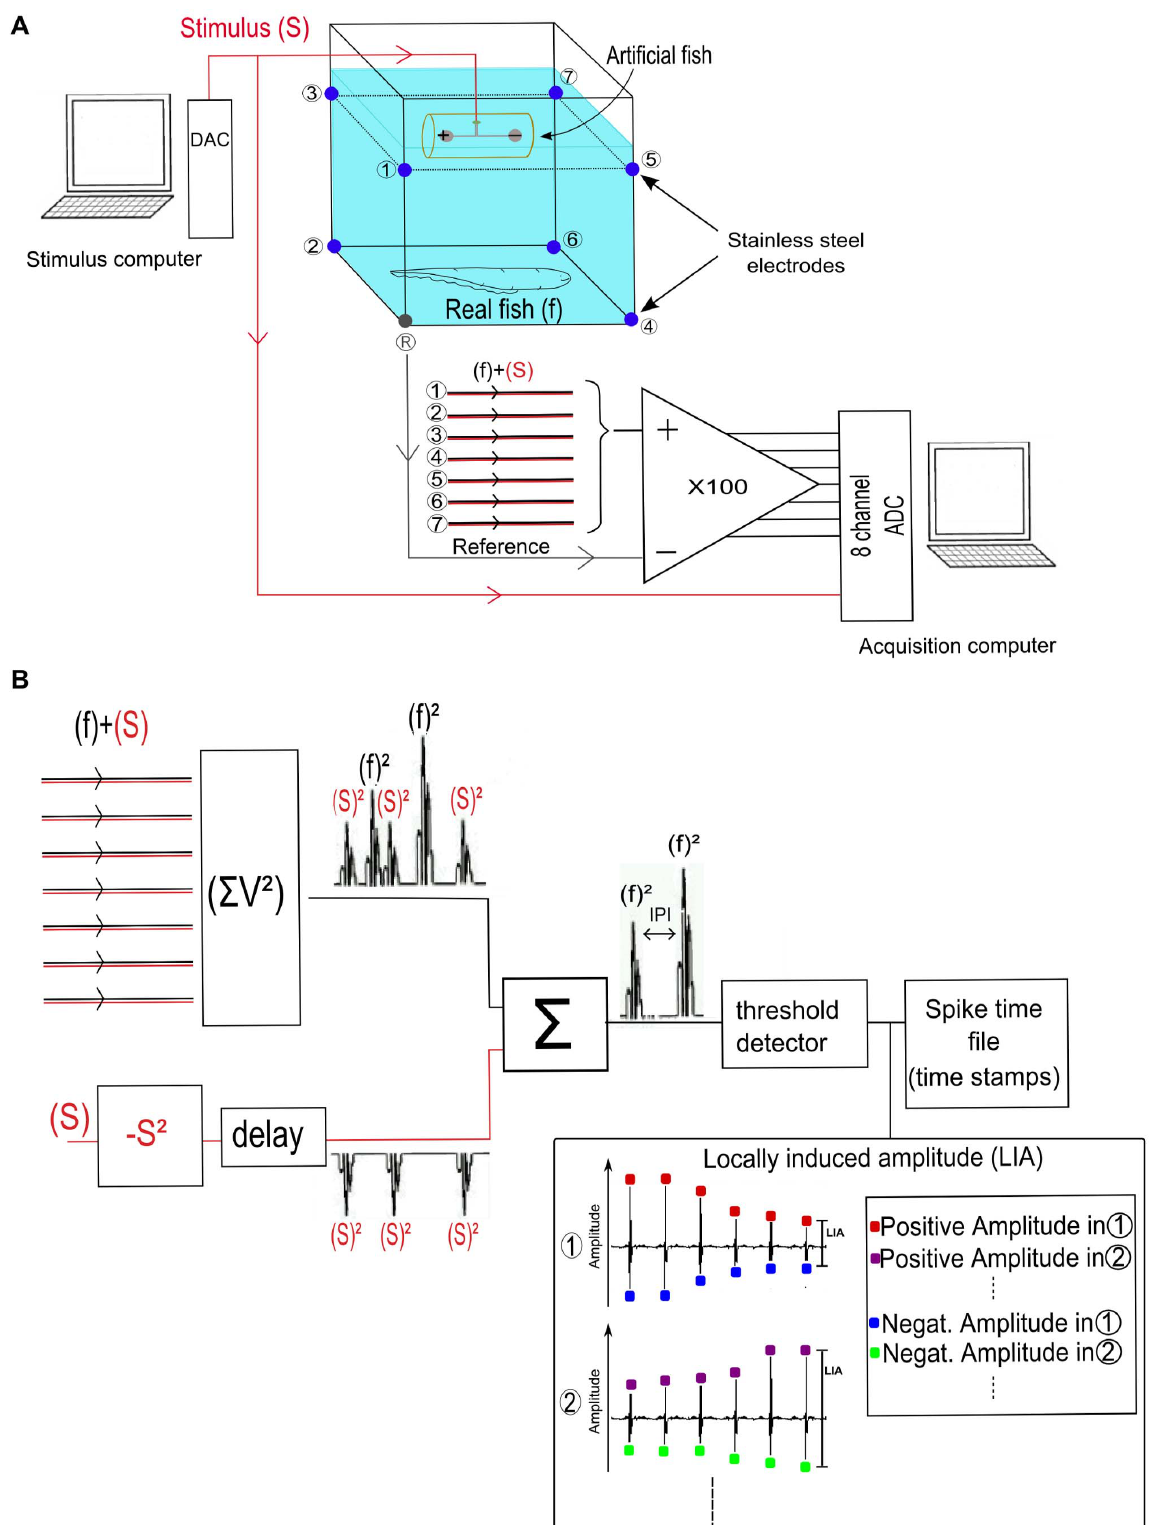
Figure 1. Acquisition and stimulation setup. A – hardware: EODs from real (f) and artificial stimulus (S) fish are measured using a 3D array of 8 electrodes [(1)-(7), and (R)]. Signals are differentially amplified (x 100, (R) is the common reference) and digitized at 50 kHz by an ADC board. The artificial fish is a dipole electrode inside a 15 cm PVC pipe driven by a DAC output from a computer running real-time home made stimulation software that mimics a real fish pulse shape with IPIs defined by the experimenter. B – acquisition software: the square of the digitized artificial signal are delayed of 1–3 samples due to the DAC-ADC circuitry and subtracted from the squared and summed electrode signals, because this signal